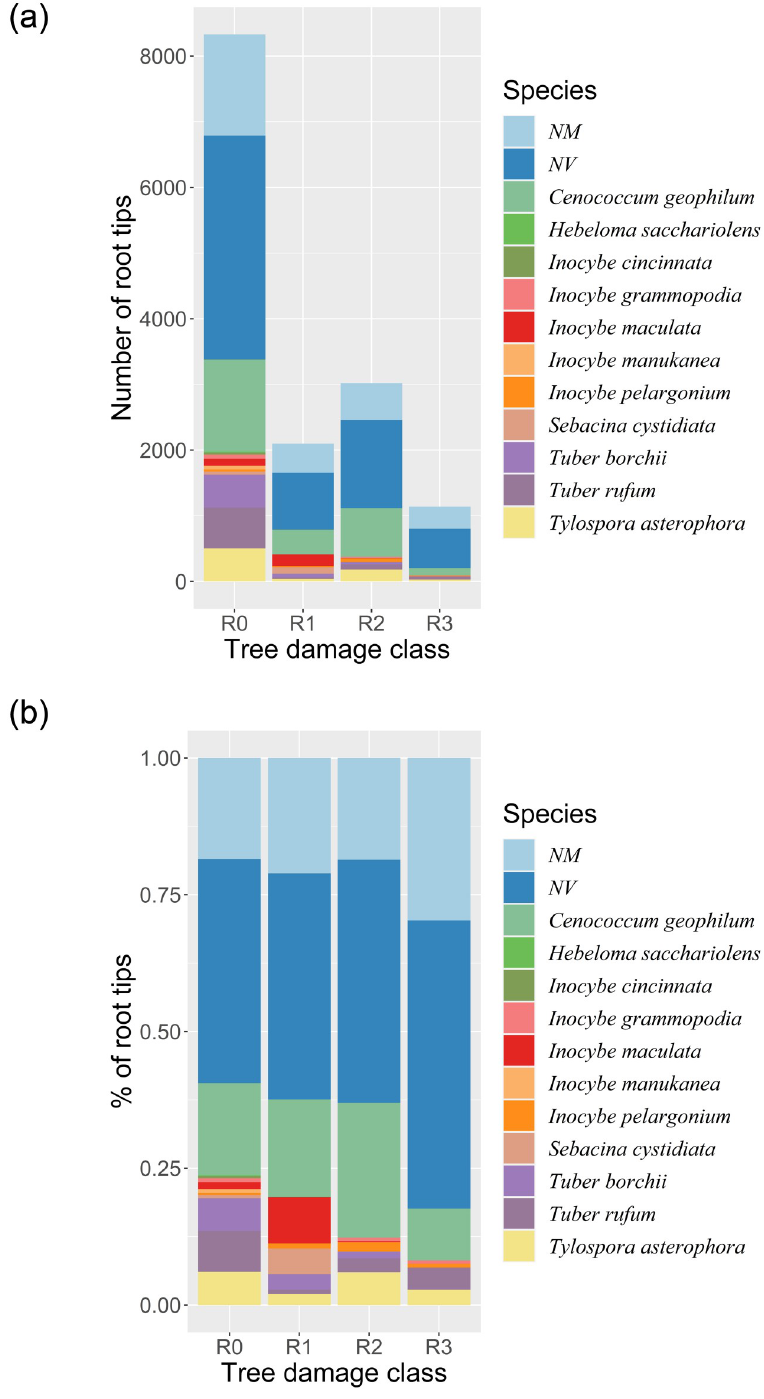
Fig 2. (a) The abundance of ectomycorrhizal, non-vital (NV) and non-mycorrhizal (NM) root tips for trees of different damage classes. Each colour represents the number of the root tips with the observed fungi species. (b) The percentage of ectomycorrhizal, non-vital (NV) and non-mycorrhizal (NM) root tips for trees of different damage classes. Each colour represents the percentage of the root tips with the observed fungi species.